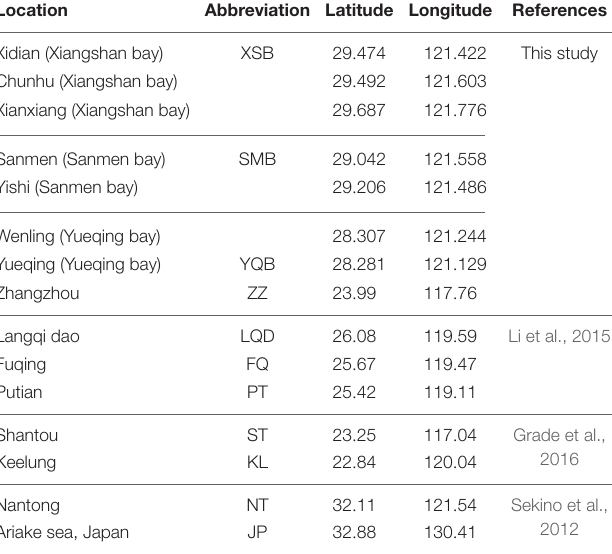
TABLE 1 | Oysters sampling sites for species